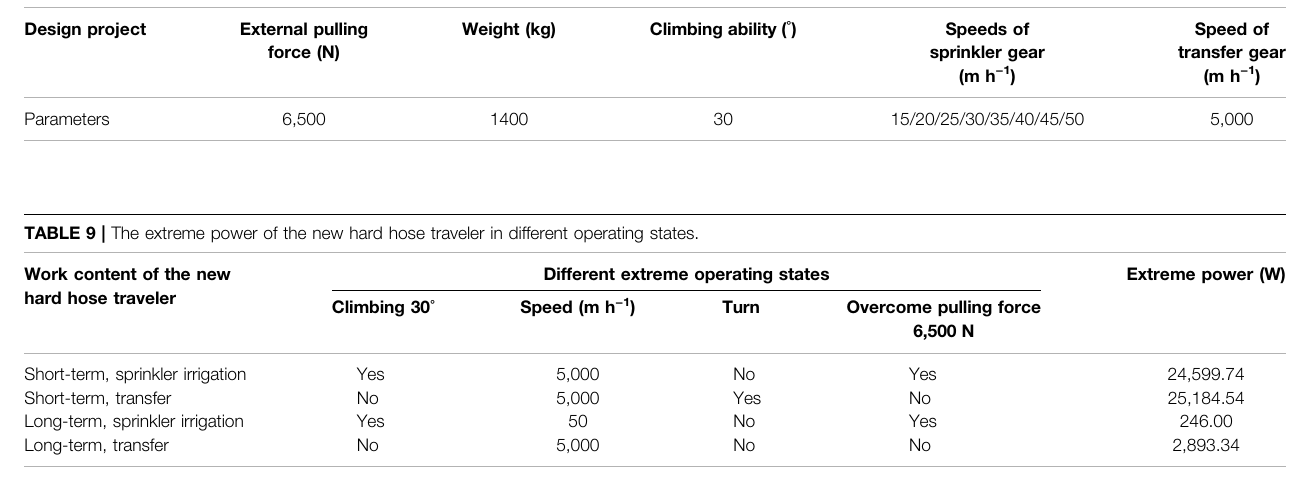
TABLE 8 | Performance parameter design of electric tracked vehicle.